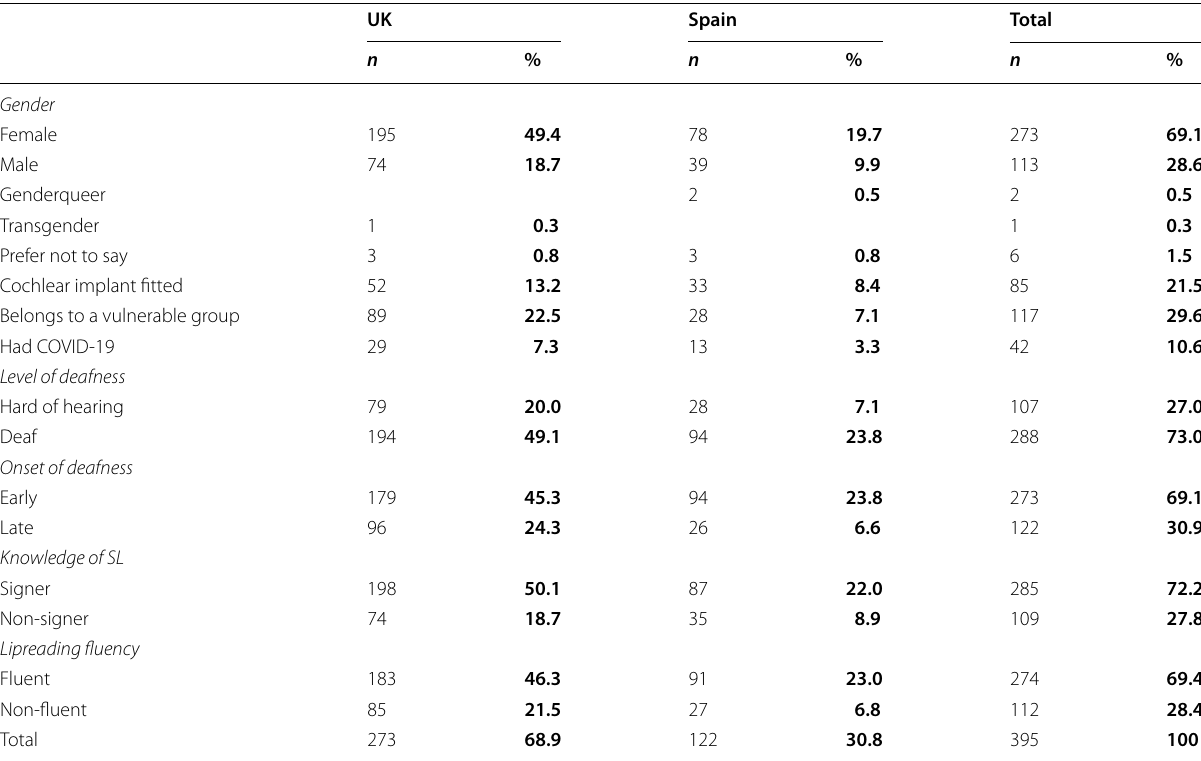
Table 2 Participants’